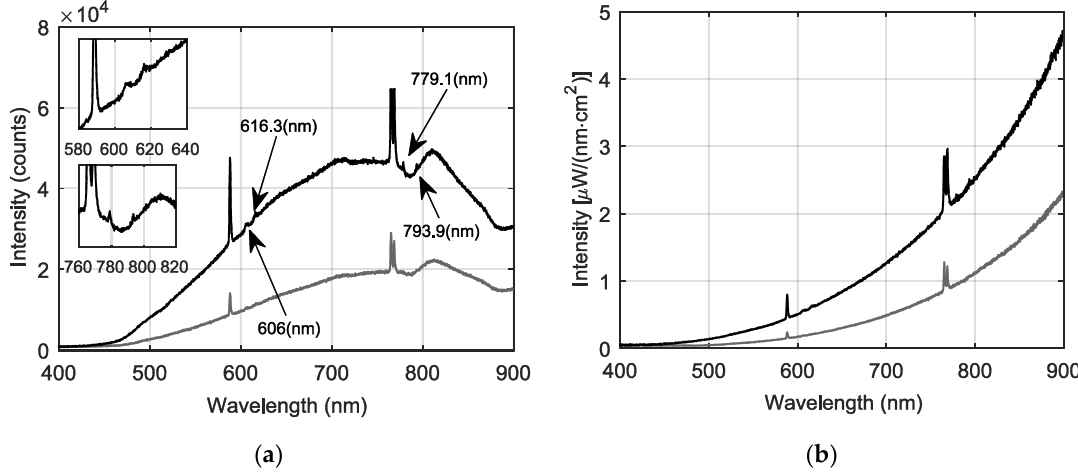
Figure 4. Emitted spectra during the flash smelting process in a flash smelter (real plant): ( a ) Uncalibrated Figure spectra; ( b ) Calibrated spectra.